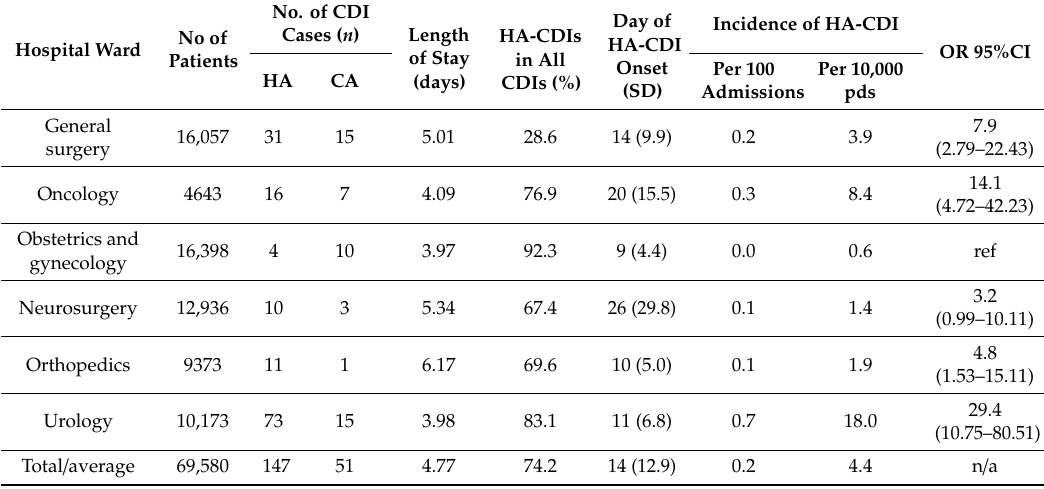
Table 1. Epidemiology of Clostridioides di ffi cile infections (CDI) in the surgical wards at St Luke’s Provincial Hospital, Tarnow, in 2012–2018.